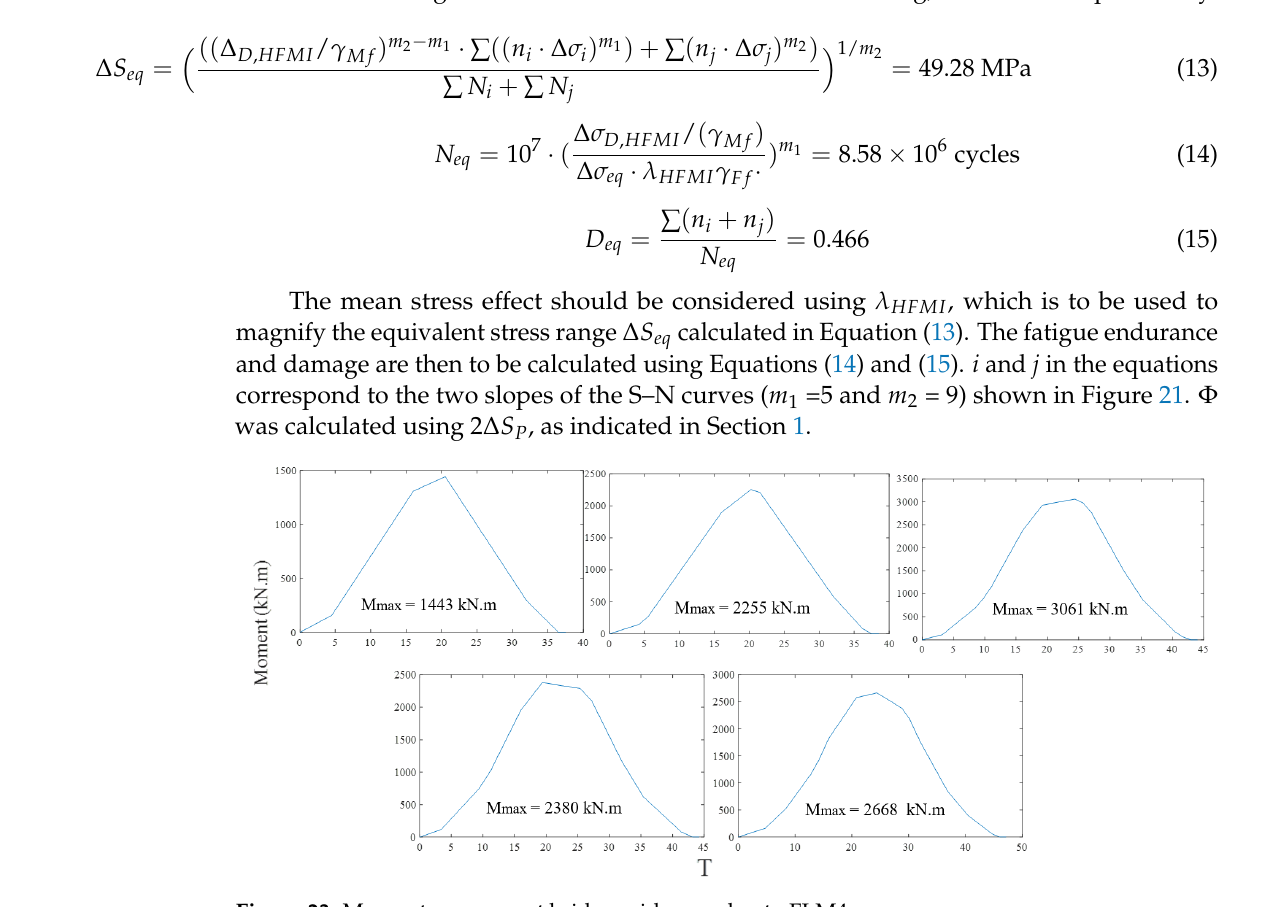
Figure 23. Moment response at bridge mid-span due to